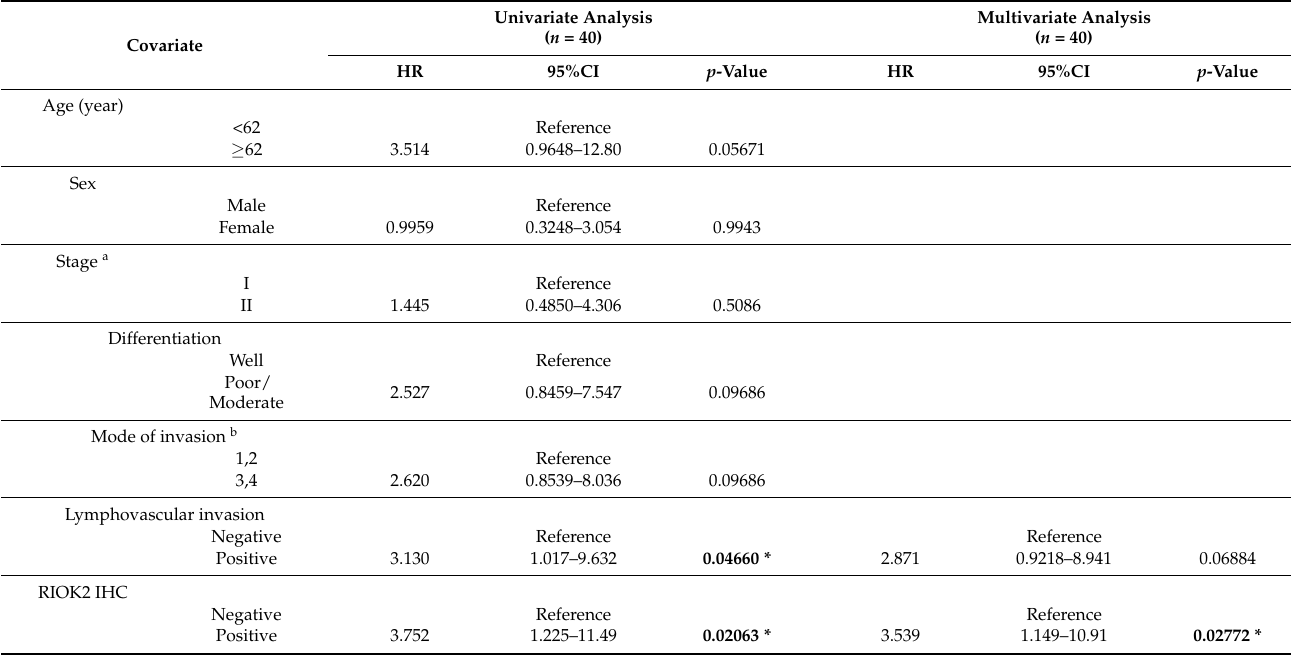
Table 2. Hazard ratios for deaths due to stage I/II tongue cancer; Cox regression model.